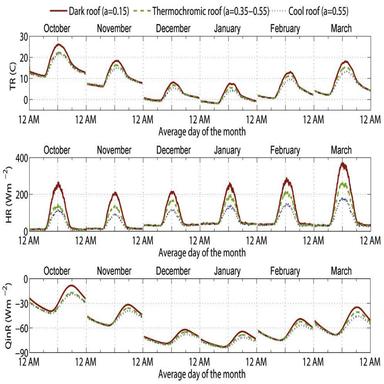
Dark (α = 0.15), thermochromic (α = − 0.35 0.55) and cool (α = 0.55) external roof surface temperature (TR), outward sensible heat flux (HR) and inward heat flux (QinR) monthly-averaged diurnal cycles for the six autumn and winter months.